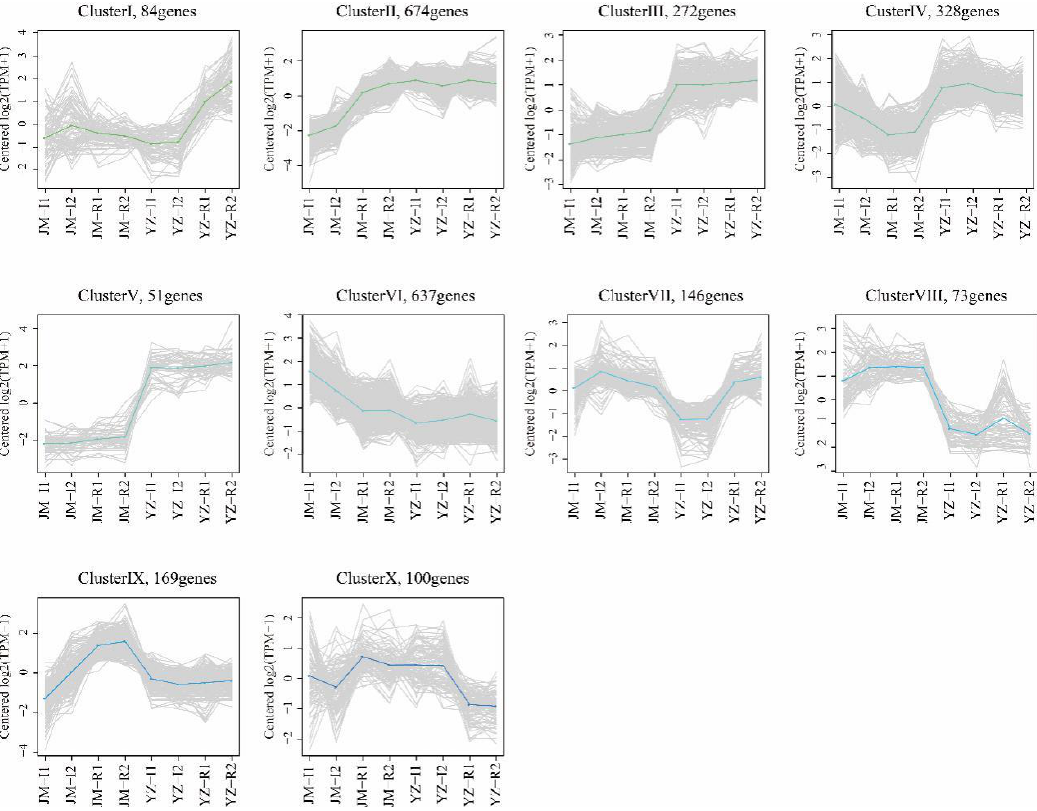
Figure 5. Cluster analysis of the differentially expressed genes. JM = the Jimai No. 47 (drought-tolerant) and YZ = Yanzhan No. 4110 (drought-sensitive); I = irrigation; R = rain-fed (drought) .